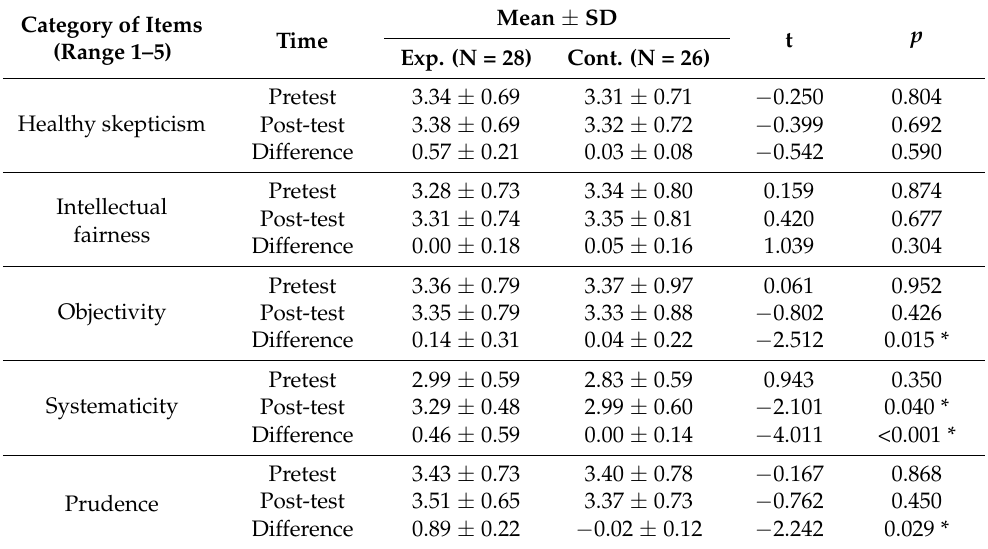
Table 3. Effects of the e-PBL-based infection control educational program for NH staff (N = 54). Category of